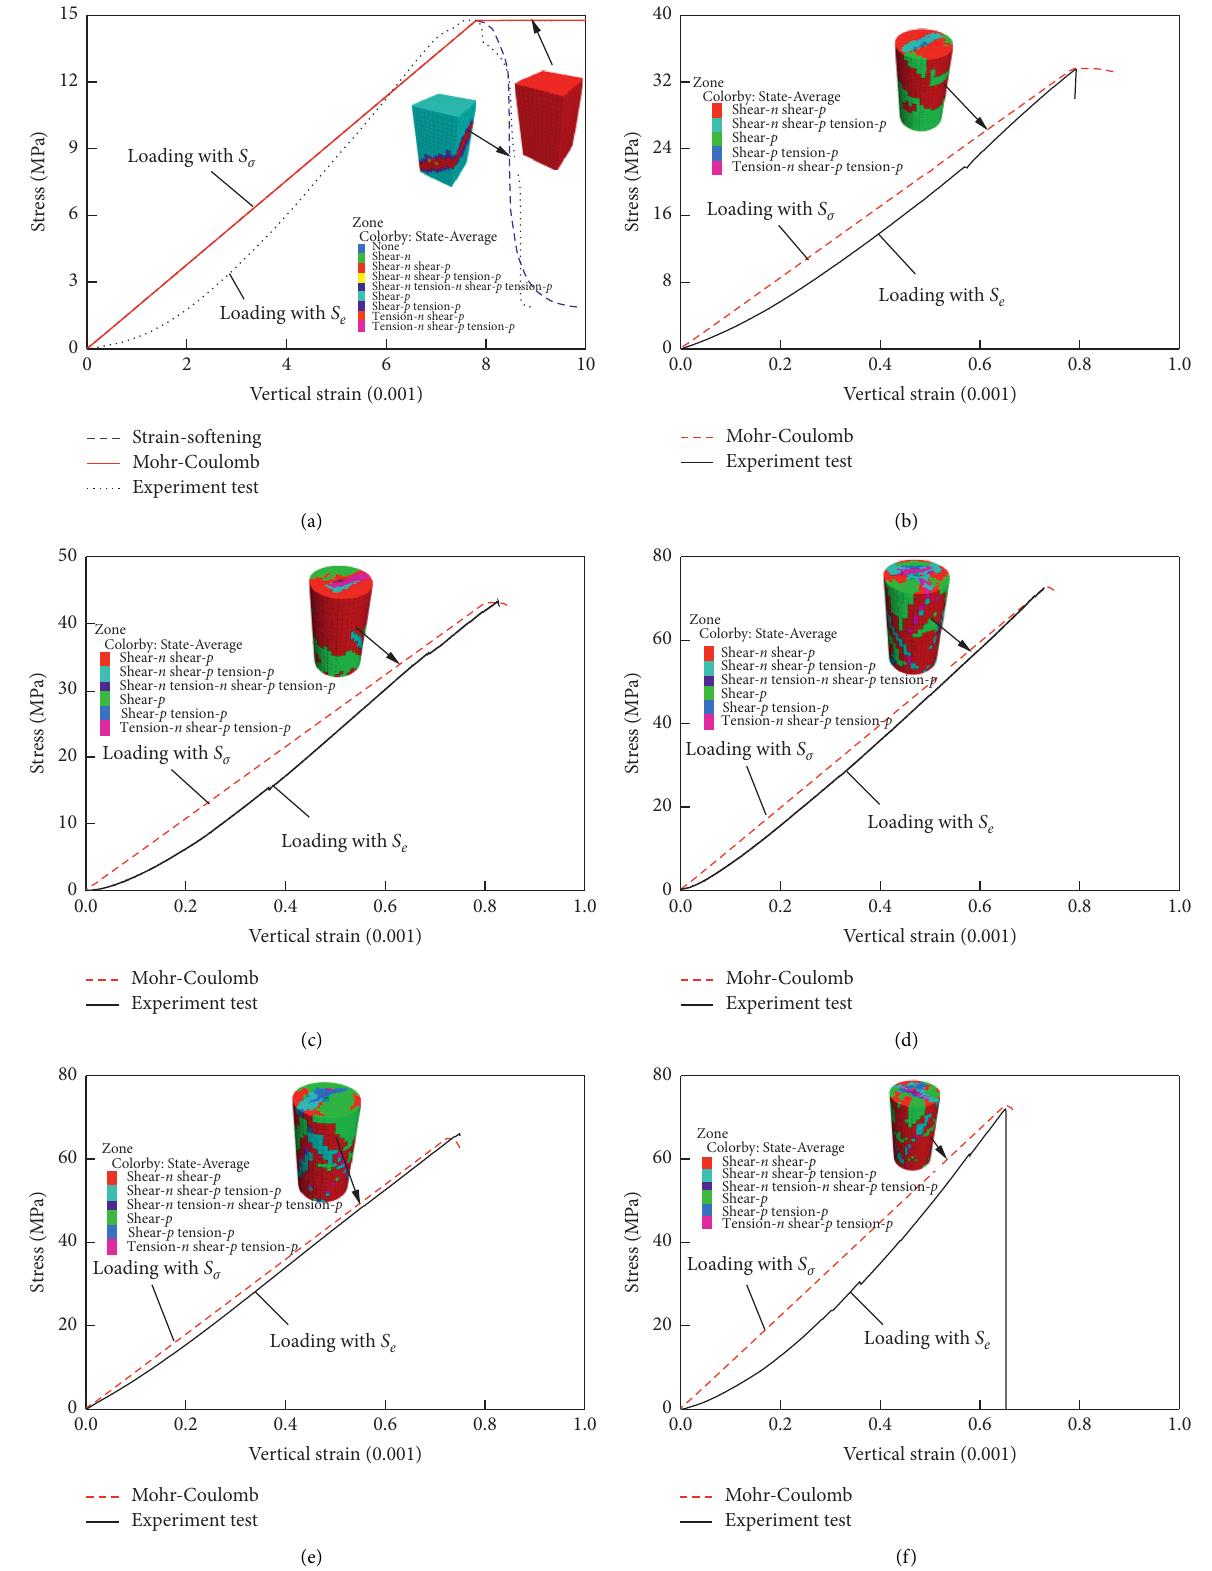
Figure 3: Relationship between stress and strain under uniaxial compression test. (a) Sample of coal. (b) Sample of mudstone. (c) Sample of sandy mudstone. (d) Sample of sandstone. (e) Sample of limestone. (f) Sample of fine